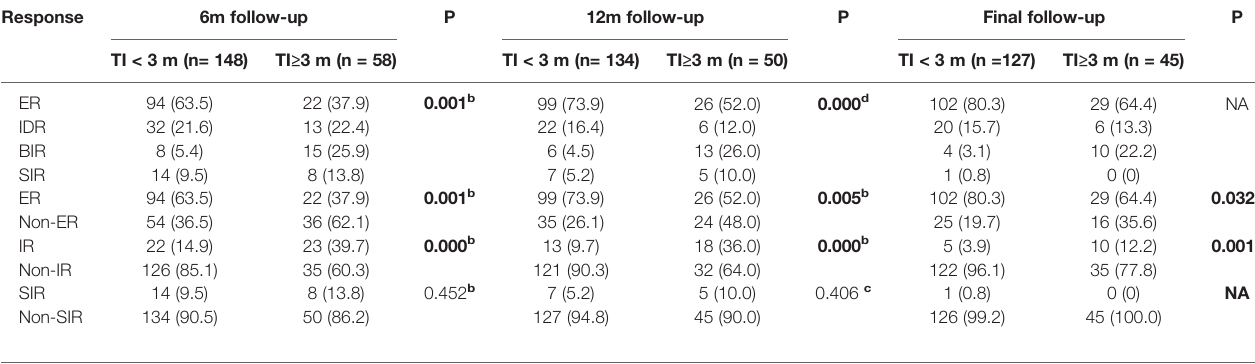
b means Pearson Chi-squared test. c means Chi-squared test (continuity correction). d means Chi-squared test ( fi sher ’ s exact). NA means not